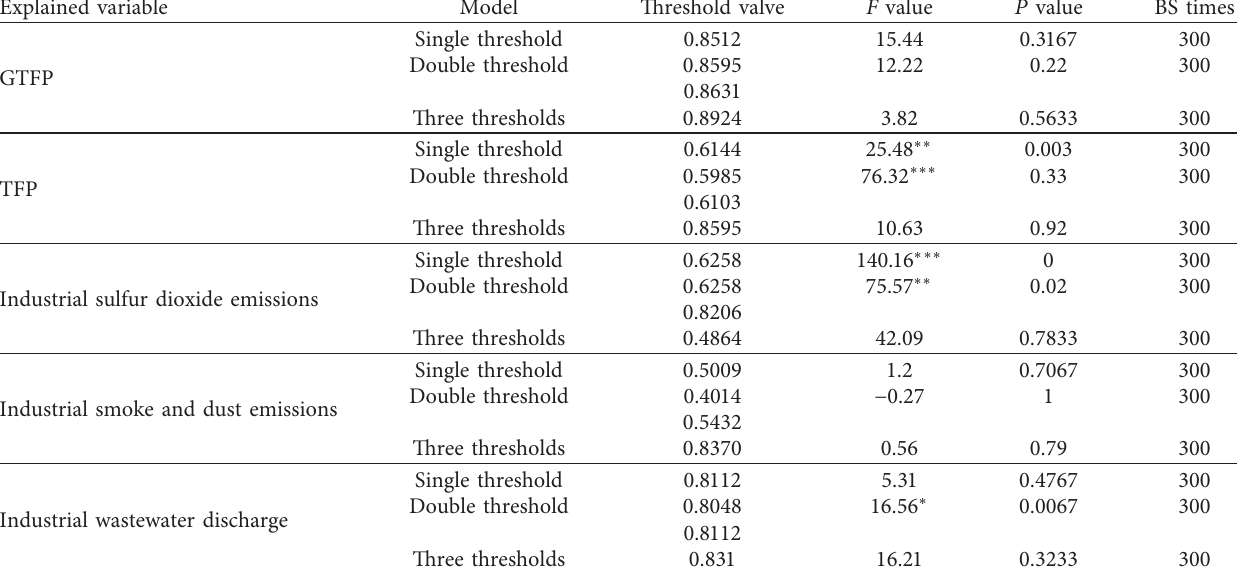
Table 6: Threshold effect test of the lag term.